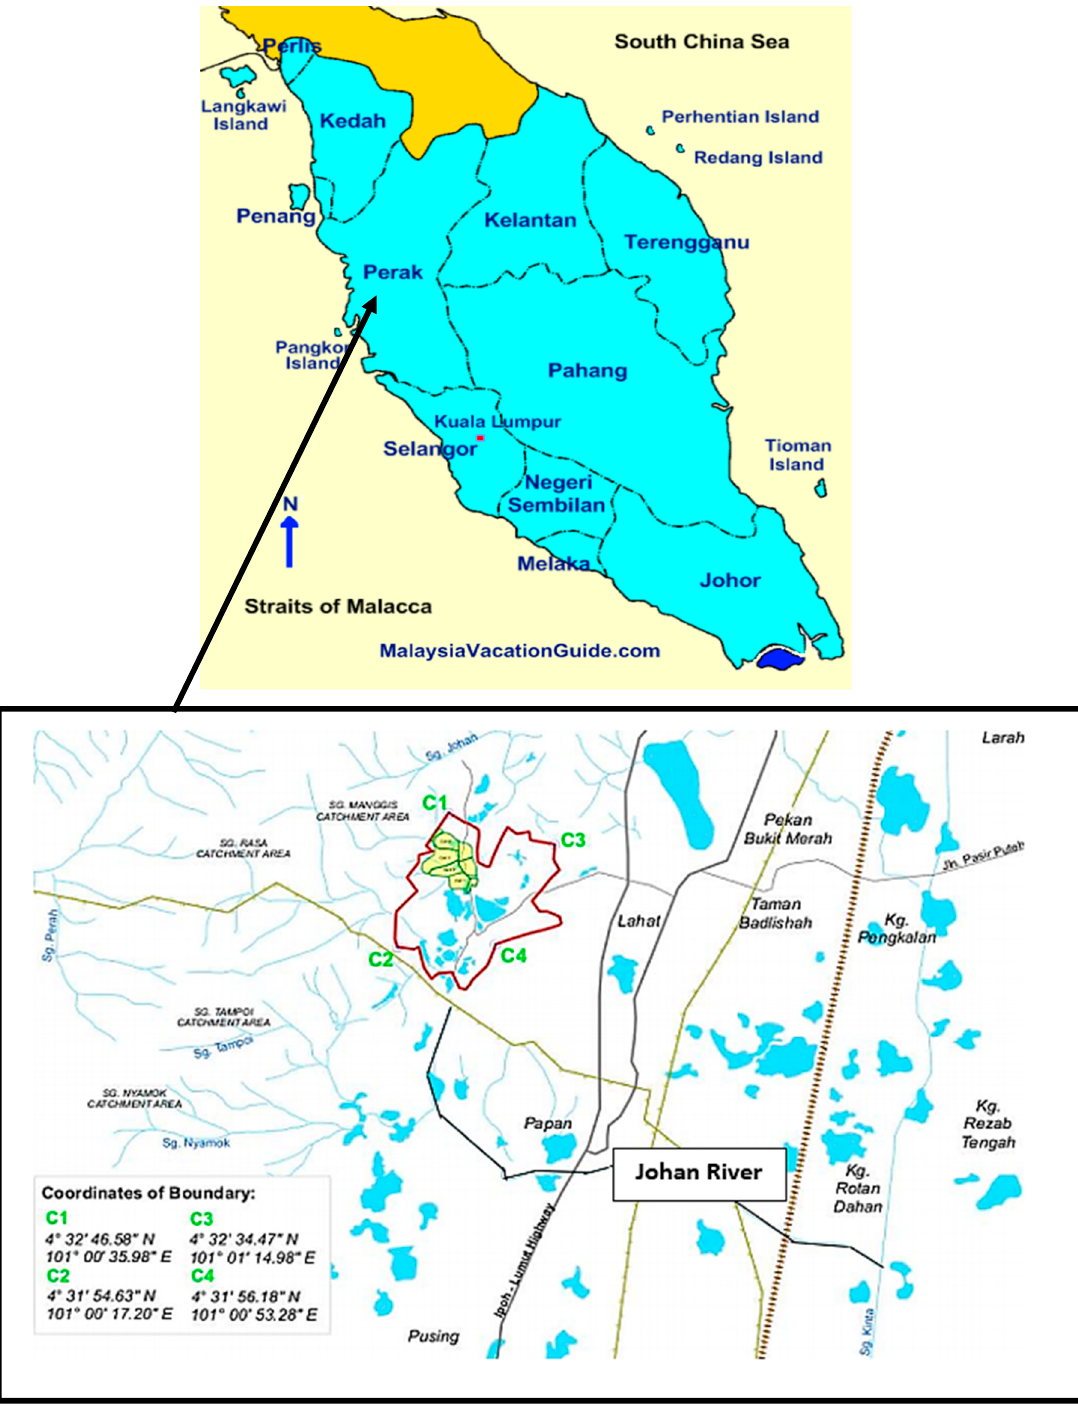
Figure 1. Papan landfill [17,18].